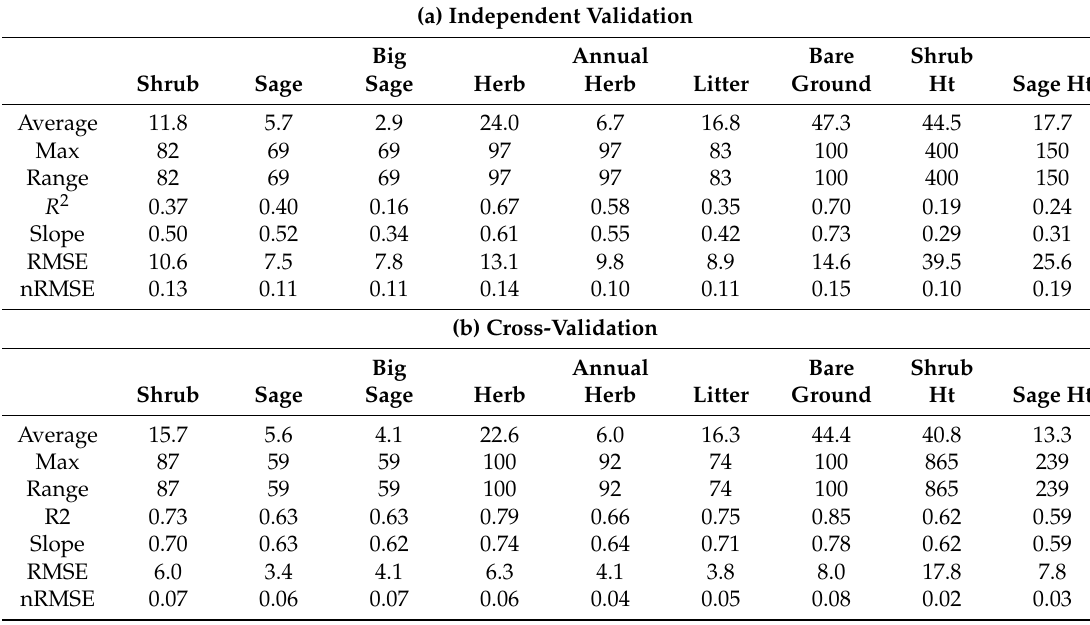
Table 2. Validation results of component predictions compared to ( a ) independent